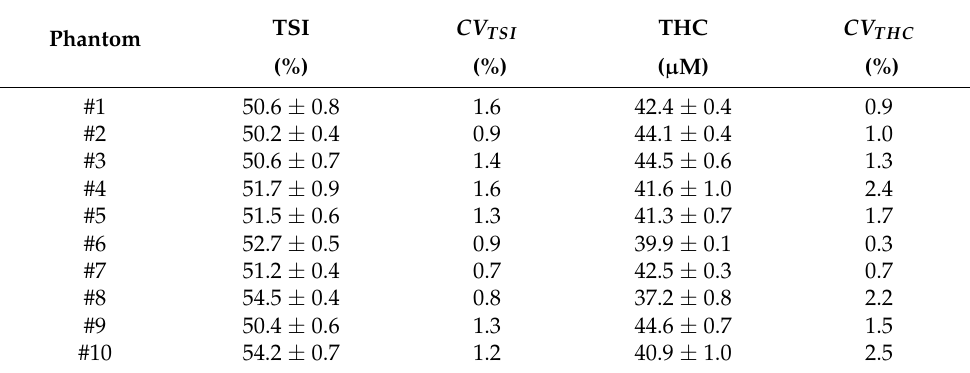
Table 3. Type 2 phantoms measured with device id50. See text for details. Values reported for each phantom are average and standard deviation (and corresponding CV) for the three different days of